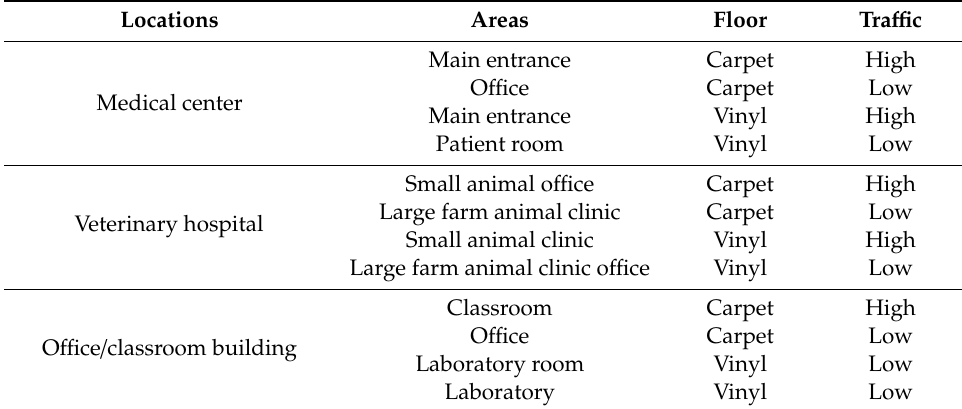
Table 1. Summary of sampling locations (and areas within), floor types and tra ffi c types.